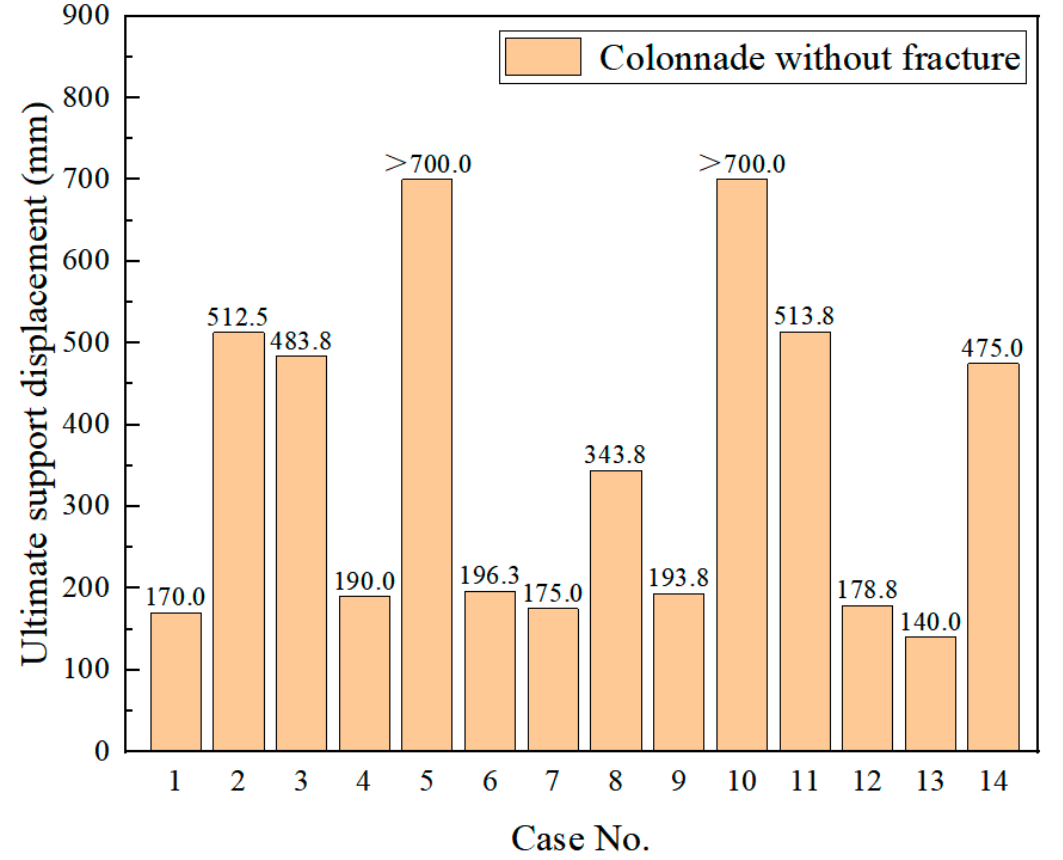
Figure 9. Ultimate support displacement of the colonnade without considering fracture.